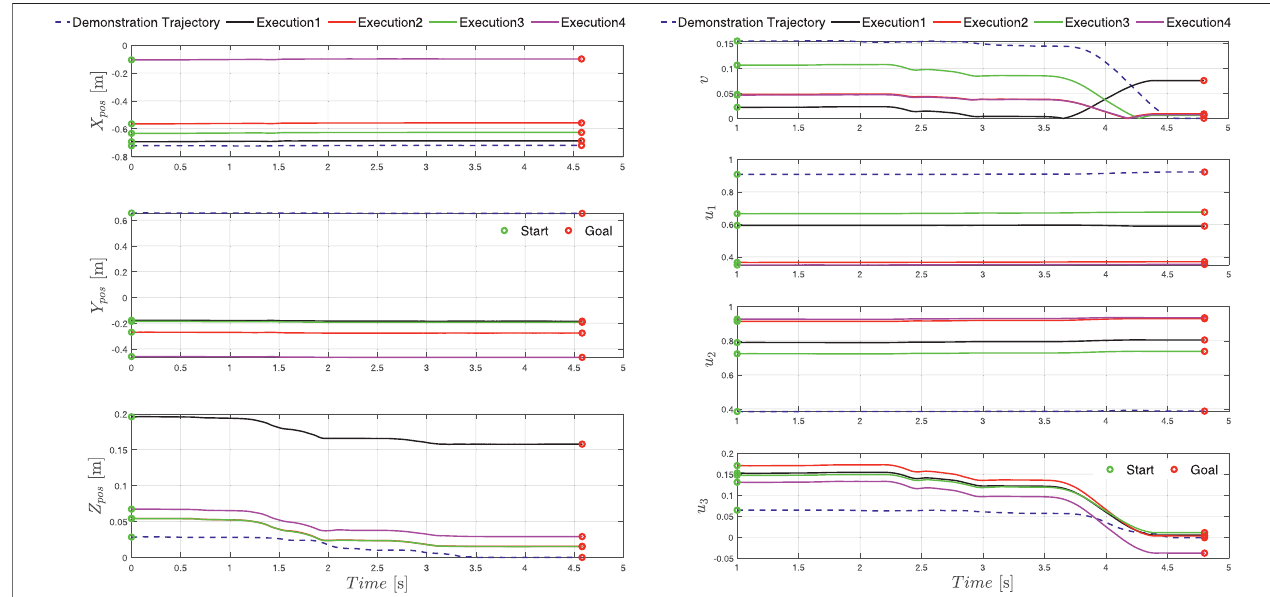
FIGURE9| Executionposition (left) andorientation (right) trajectoriesrecordedat fi velocationsintheworkspaceoftherobot.Thegoallocationgivenbytheglobal design unit is depicted as a red circle, whereas the transformed start location of the trajectory is presented with a green circle. The demonstrated trajectory is depicted with dashed lines and the transformed executed trajectories are presented with solid lines.